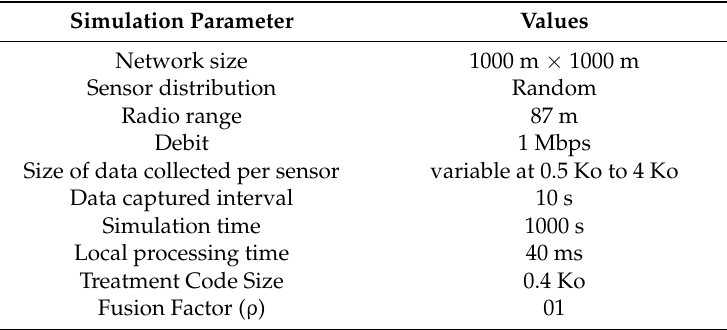
Table 1. Basic simulation